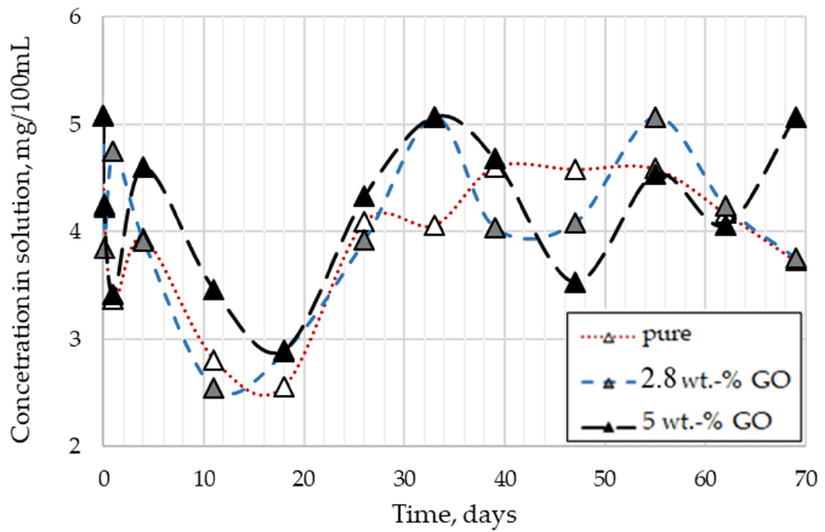
Figure 3. Sorption of IBU by pure 6FDA-DAM:DABA 3:1 and with different loadings of graphene oxide.